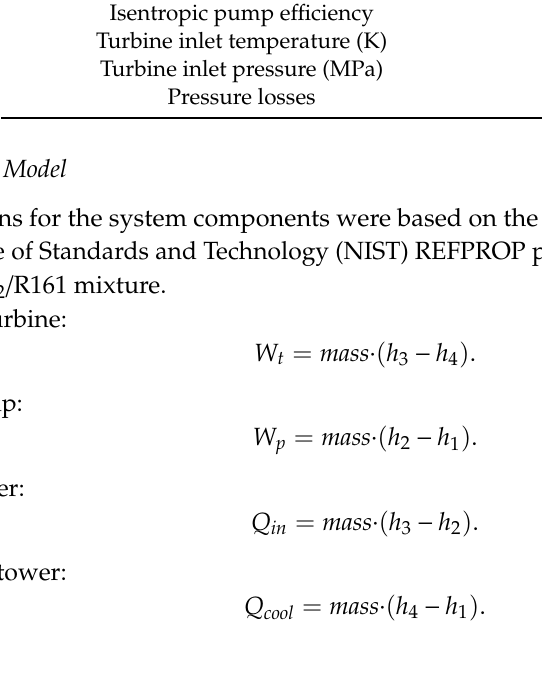
Figure 3. The critical pressure and critical temperature for CO 2 /R161 mixtures.